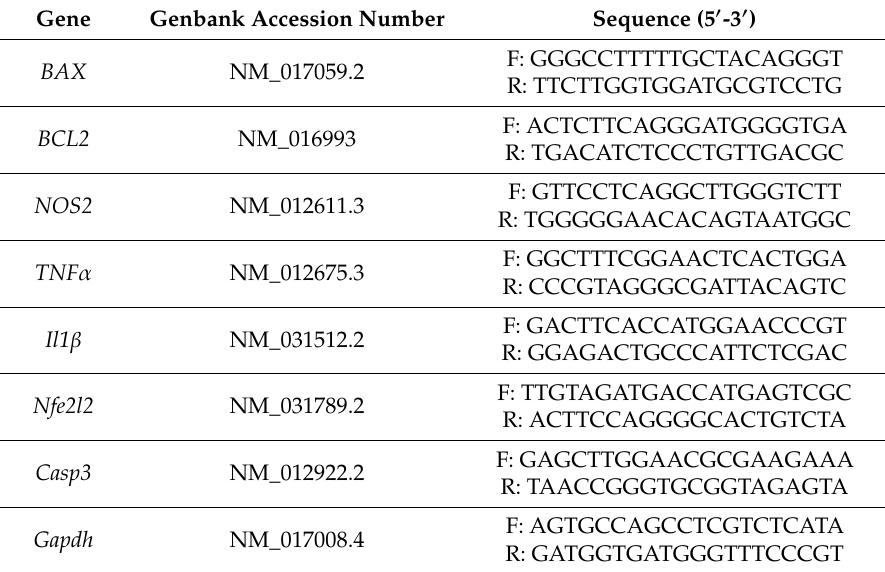
Table 1. Primers used for